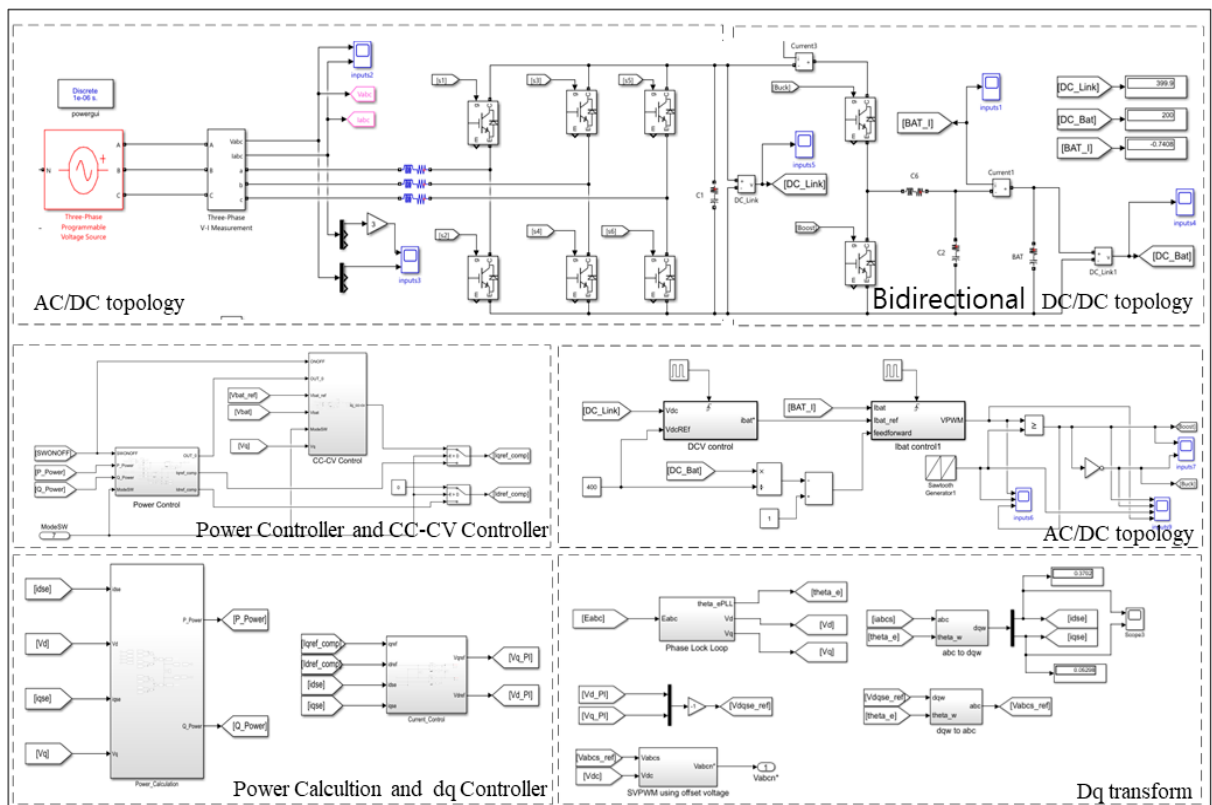
Figure 21. Simulation block diagram of power compensator control. Table 2. Power compensator simulation parameters.